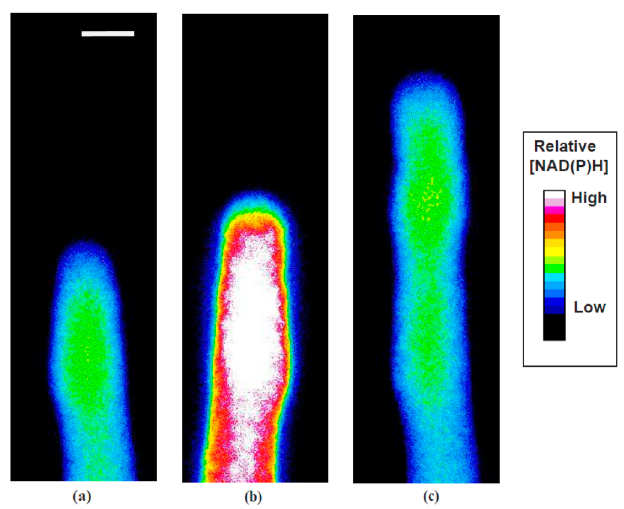
Figure 2. NAD(P)H; individual frames from a representative time lapse video illustrating significant spatial distributions of NAD(P)H fluorescence in a pollen tube transiently exposed to 200 µM KCN: ( a ) NAD(P)H fluorescence in an oscillatory pollen tube before KCN treatment; ( b ) maximum NAD(P)H fluorescence when growth is maximally inhibited by KCN; ( c ) return to normal NAD(P)H fluorescence after KCN is removed and oscillatory growth resumes. Bar in panel ( a ) corresponds to 10 µm.